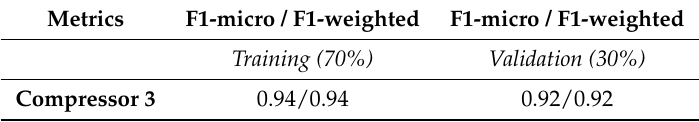
Table 3. Performance of 1D CNN with training and validation sets from compressor